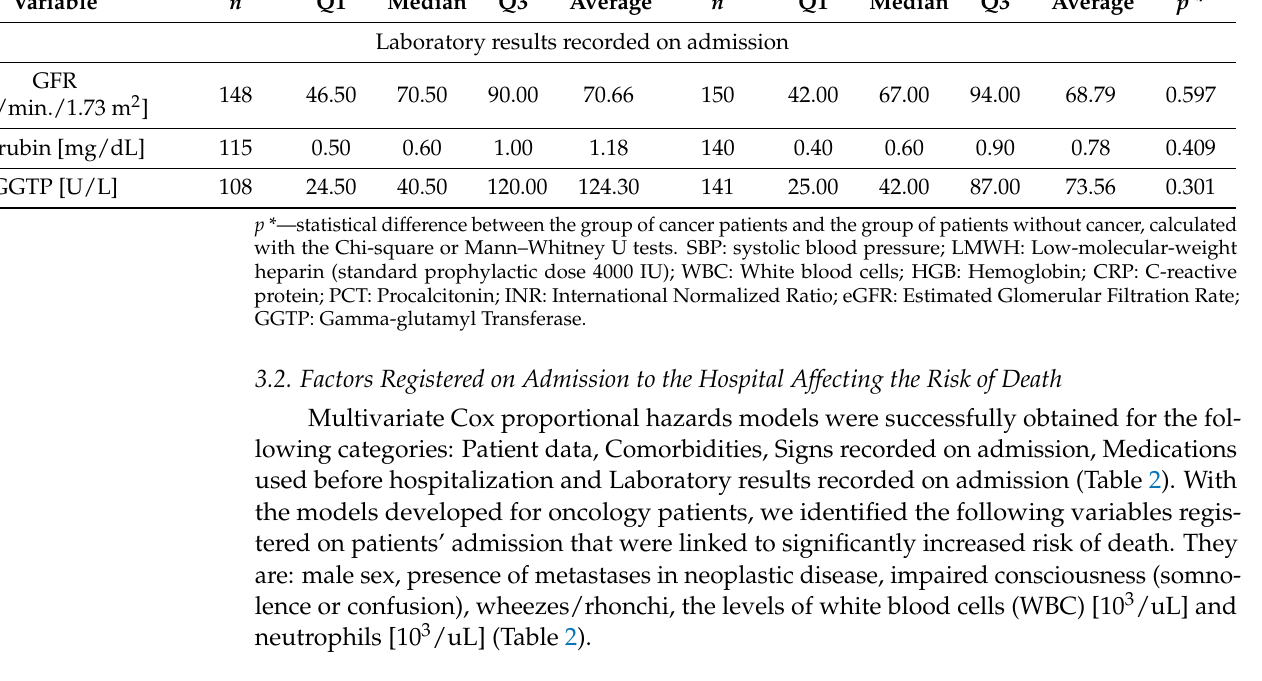
Table 2. Multivariate Cox proportional hazards models. Significant factors marked with